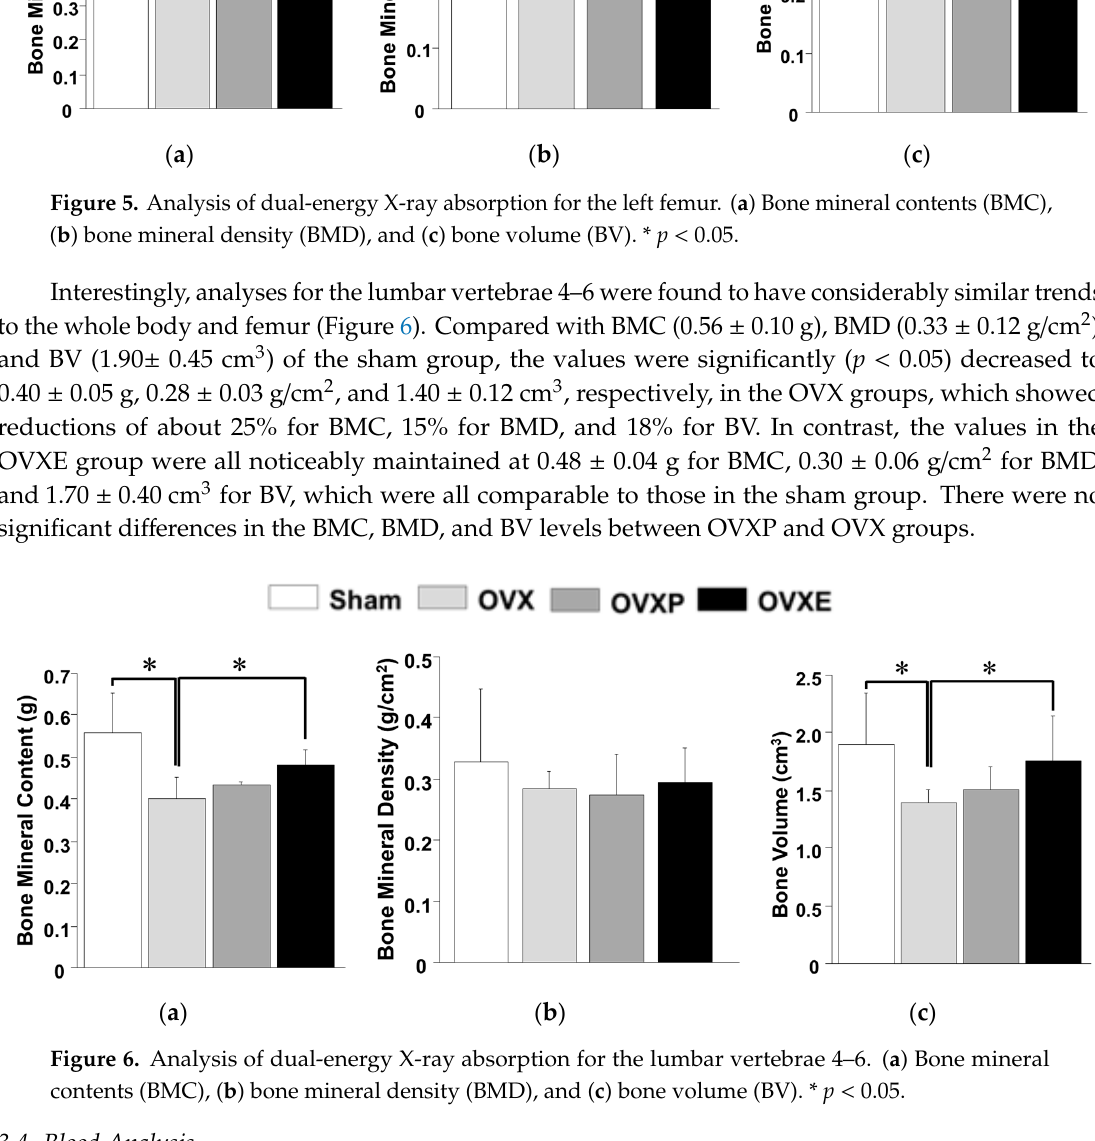
Figure 5. Analysis of dual-energy X-ray absorption for the left femur. ( a ) Bone mineral contents (BMC), ( b ) bone mineral density (BMD), and ( c ) bone volume (BV). * p < 0.05.